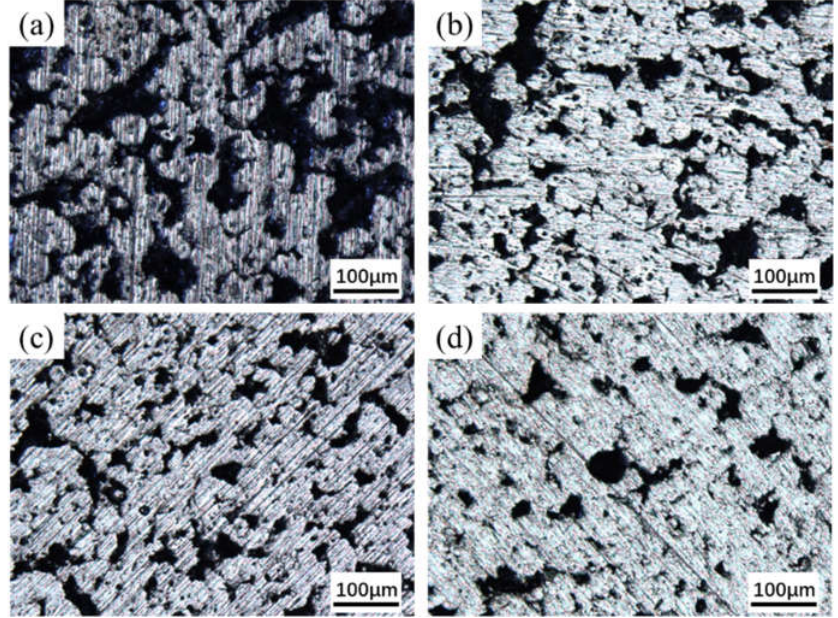
Figure 2. Optical micrographs of porous NiTi alloys prepared at various temperatures: ( a ) 950 °C; ( b ) 1000 °C; ( c ) 1050 °C; ( d ) 1100 °C .